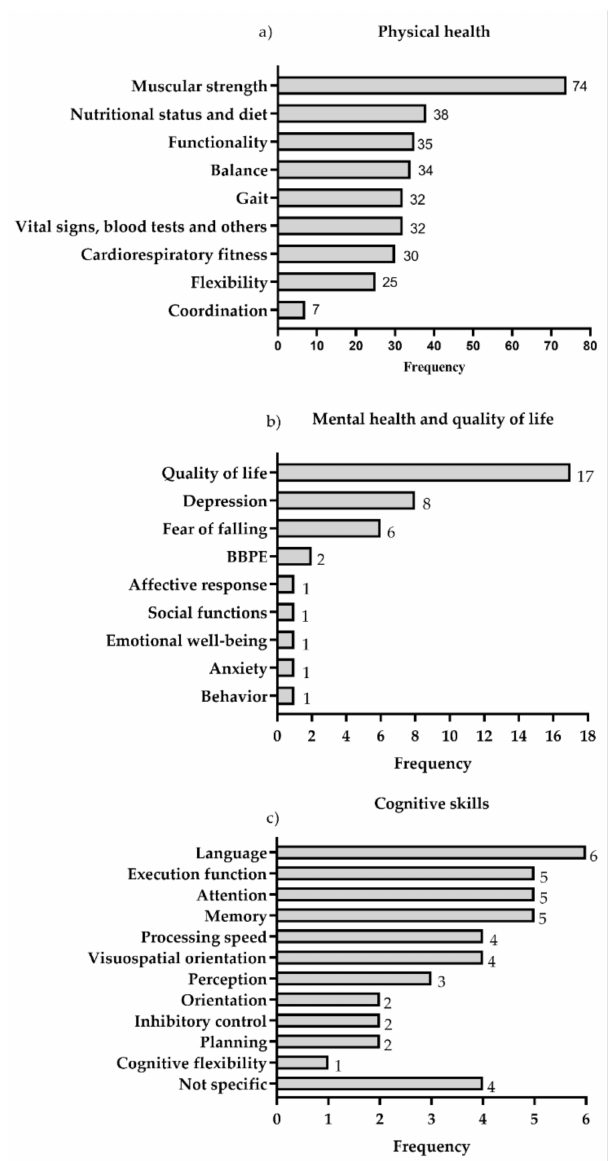
Figure 3. Variables of ( a ) physical health, ( b ) mental health and quality of life and ( c ) cognitive skills. The data are presented in absolute frequency. BBPE: Barriers and Benefits Perceived for the Execution of the